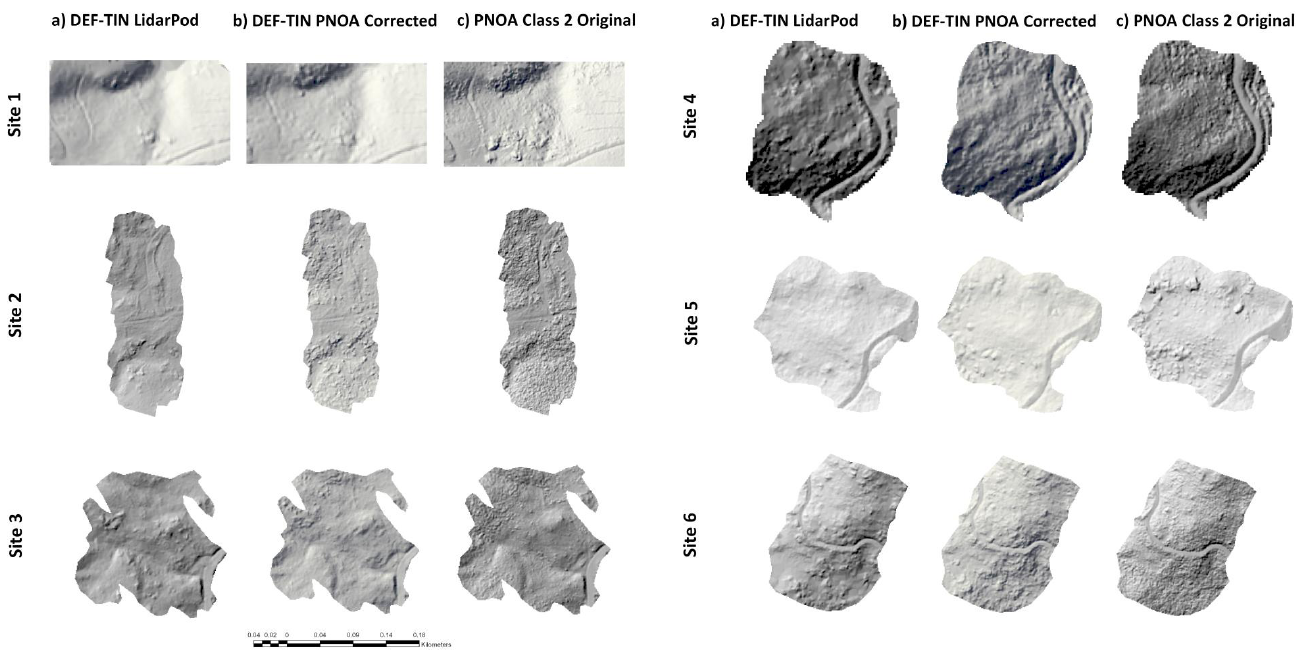
Figure 5. Hillshades of DEMs using the TIN densification filter with default parameters (DEF) (at 1 m pixel size for better interpretation) from: ( a ) high-density LiDAR; ( b ) corrected low-density LiDAR and ( c ) uncorrected low-density LiDAR using the original classification